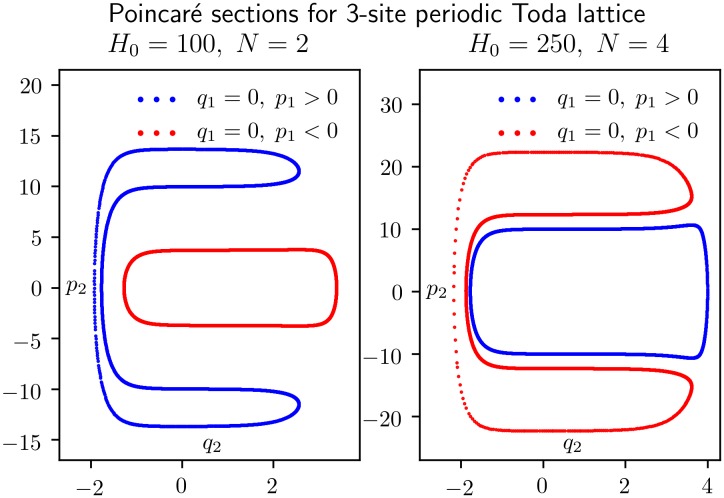
Poincaré sections for an orbit of the reduced 3-site Toda lattice model of Eq (11).Each panel shows 4000 crossings of the (q1 = 0)-plane, 2000 in the positive direction (p1 > 0, marked blue), and 2000 in the negative direction (p1 < 0, marked red). The dynamics between each crossing is determined by KiMoKi solvers of order 2 (left panel) resp. 4 (right panel), with timestep τ = 0.005. The initial condition is z0 = (0, 1, 9.95073, 10), with H0 = 100, C3⊥ = −15852.72982, for the left panel, and z0 = (0, 1, 19.97541, 10), with H0 = 250, C3⊥ = 16117.70199, for the right panel.